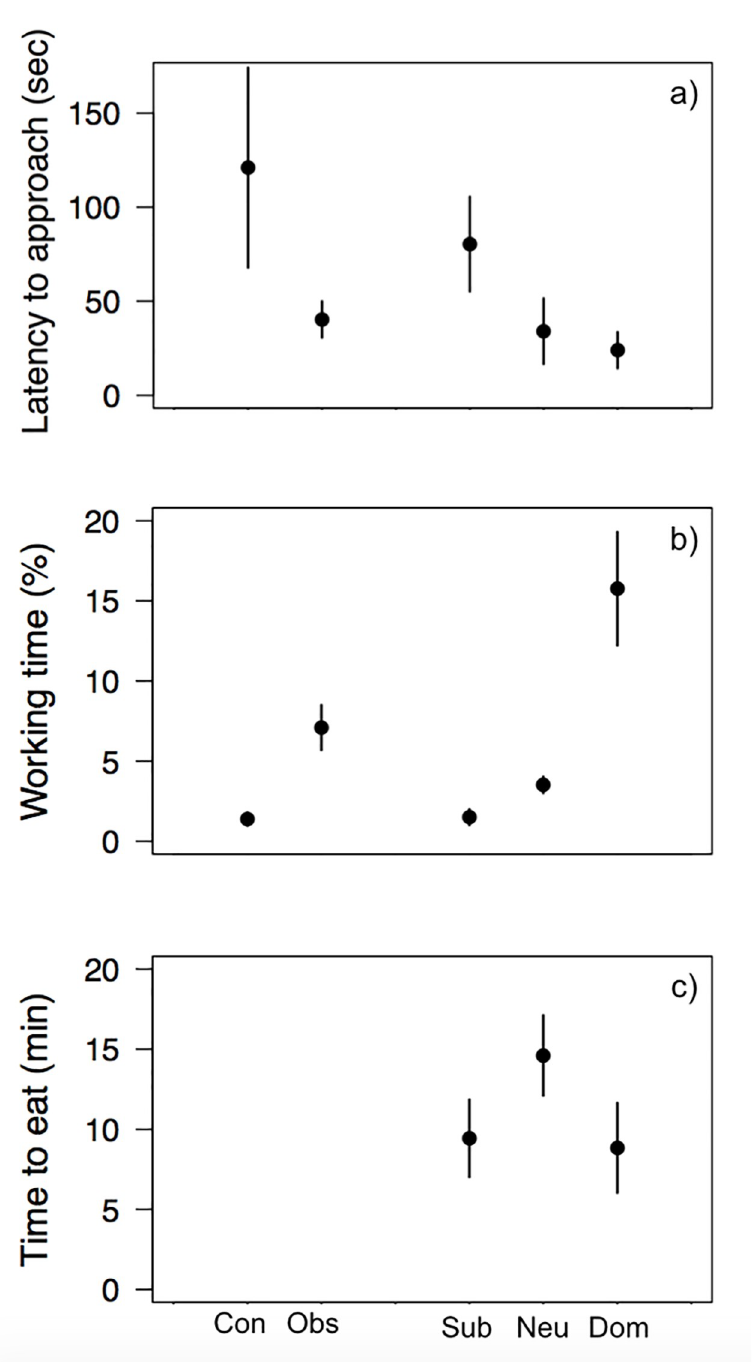
Fig 4. Mean time ± SE in Study 3 for control (Con) and observer (Obs) coyotes, and for subordinate (Sub), neutral (Neu) and dominant (Dom) individuals within the observer treatment group (a) required to approach the experimental apparatus (seconds) and (b) spent working on the problem. Mean time ± SE for subordinate, neutral and dominant unsuccessful individuals to eat the food inside the hoop during the post-trial tests